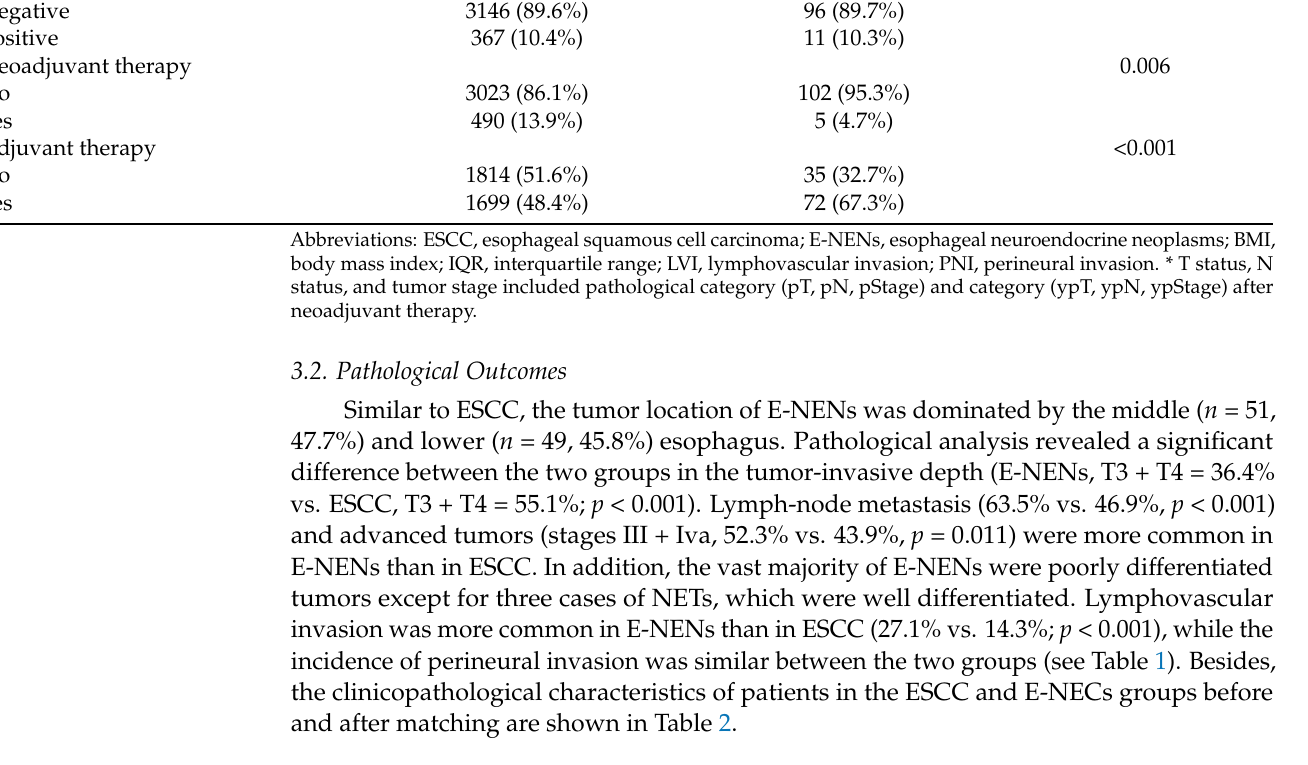
Table 2. Clinicopathological characteristics of patients in the two groups (excluding 3 cases of NETs) before and after propensity-score matching #